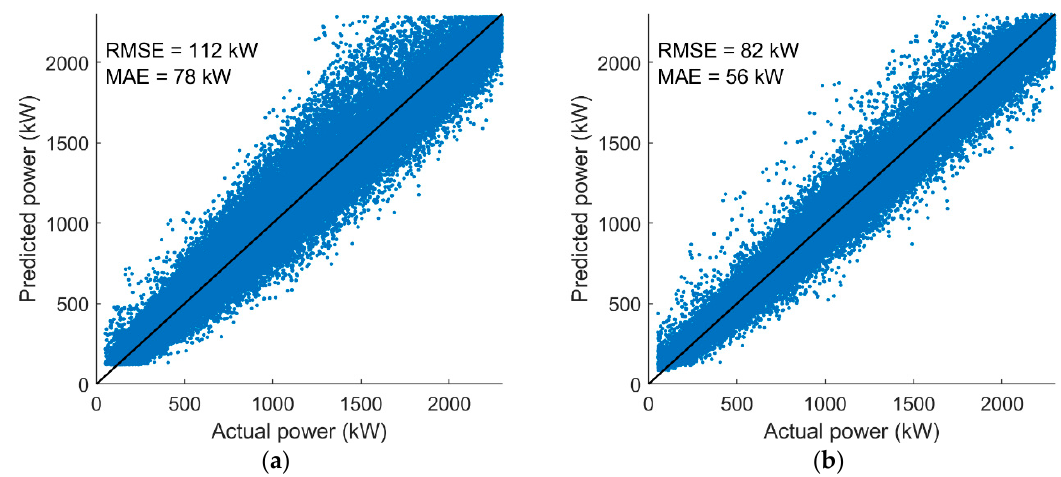
Figure 9. Performance of the standard power curve and power surface based on turbulence intensity and wind speed. ( a ) Standard power curve and ( b ) modified power surface.